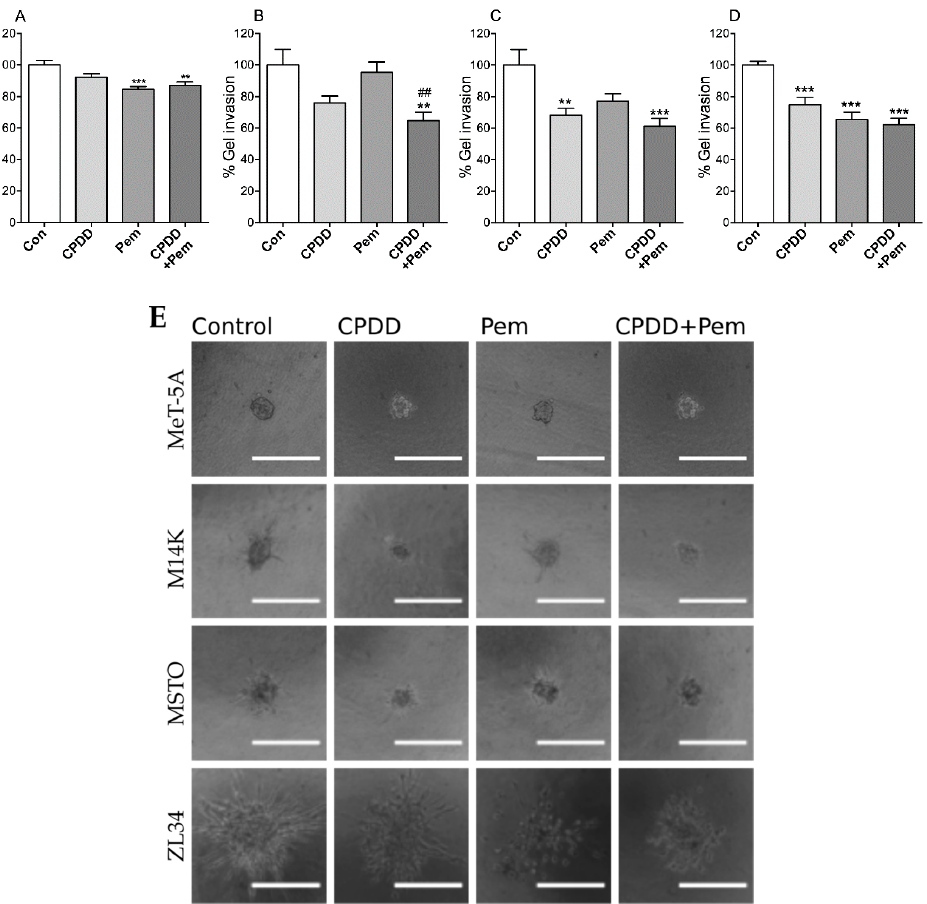
Figure 3. Mean values of perimeter of spheroid invasion ± SEM without or with treatments (CPDD, Pem, or CPDD+Pem) expressed as % of Controls ( cells with 10% FBS-RPMI ) along with representative microscopy images from each group. ( A ) MeT-5A cells ( n = 16–21), ( B ) M14K cells ( n = 19–22), ( C ) MSTO cells ( n = 13–19), ( D ) ZL34 ( n = 15–23). ** p < 0.01 and *** p < 0.001 vs. Controls, ## p < 0.01 vs. Pem. ( E ) Images of spheroids invading into the surrounding collagen matrix, arranged by rows (by cell type) and their corresponding treatments in a column wise manner. Scale bars represent a length of 100 pixels.